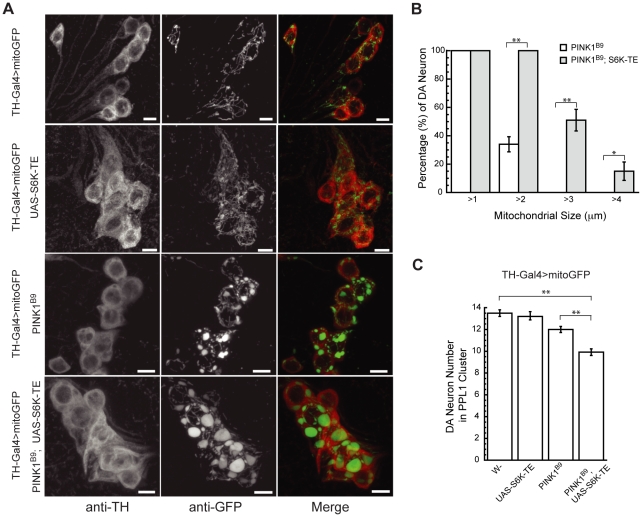
Constitutively active S6K increases mitochondrial aggregation and DA neuron loss in PINK1 mutants.(A) Overexpression of constitutively active S6K increased the size of swollen or aggregated mitochondria in the DA neurons of PINK1 mutants. Mitochondrially targeted GFP (mitoGFP) was expressed in the DA neurons using TH-Gal4 driver [44] to help visualize mitochondrial morphology. Brains of 7-day-old adult flies of the indicated genotypes were immunostained with anti-TH antibody (red) to label DA neuron and anti-GFP antibody (green) to label mitochondria. Images of DA neurons in the PPL1 cluster were shown. Overexpression of S6K-TE in PINK1 mutant significantly increased the size of mitochondrial aggregates in DA neurons. The scale bar represents 5 µm. (B) Comparison of mitochondrial size distribution in PINK1 mutants with or without S6K-TE overexpression. Statistical significance was determined by Student's t test (**P<0.001, *P<0.05). (C) Overexpression of constitutively active S6K increased DA neuron loss in the PPL1 cluster of PINK1 mutant. DA neuron number was scored in flies aged for 14 days at 25°C. At least 7 flies were used for each genotype. Statistical significance was determined by Student's t test (**P<0.001). Data are presented as mean ± s.e.m.